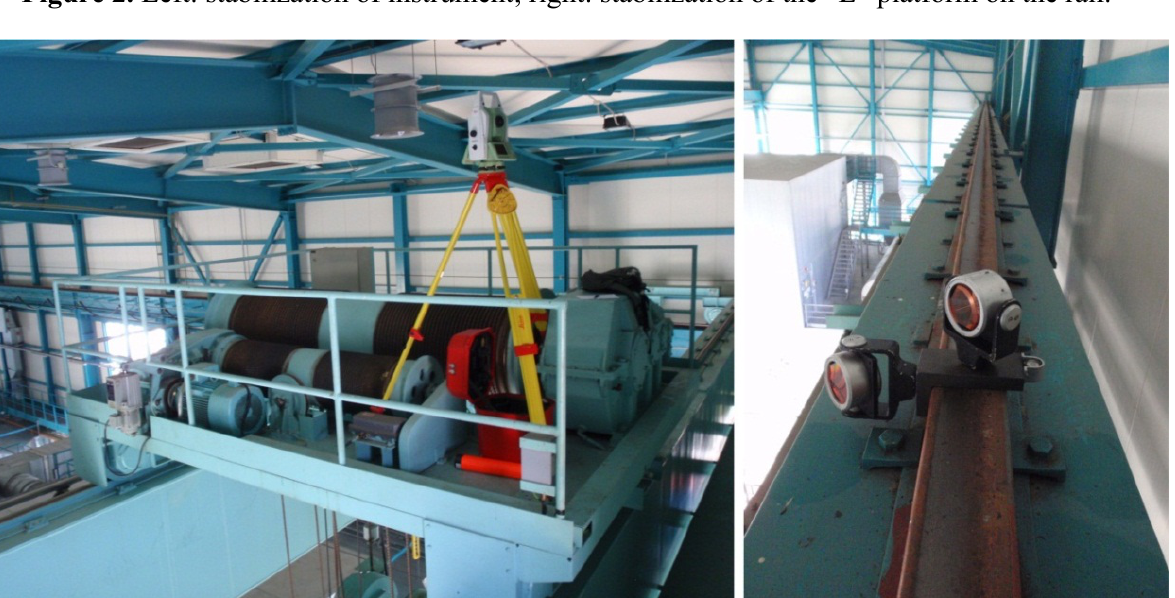
Figure 2. Left: stabilization of instrument; right: stabilization of the “L” platform on the